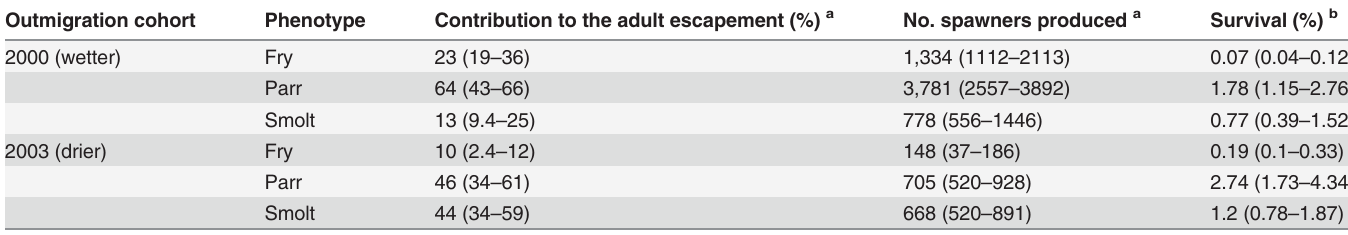
Table 4. Contribution and survival of fry, parr and smolt outmigrants to the adult